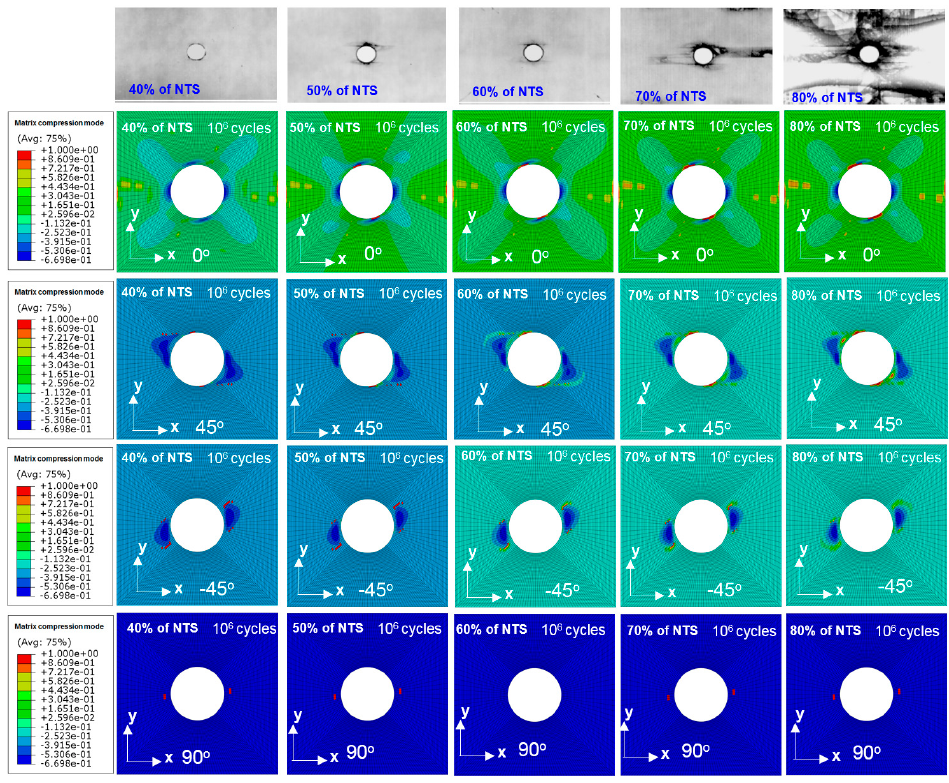
Figure 13. Matrix compression failure index after 10 6 cycles in the quasi-isotropic OHT specimen.